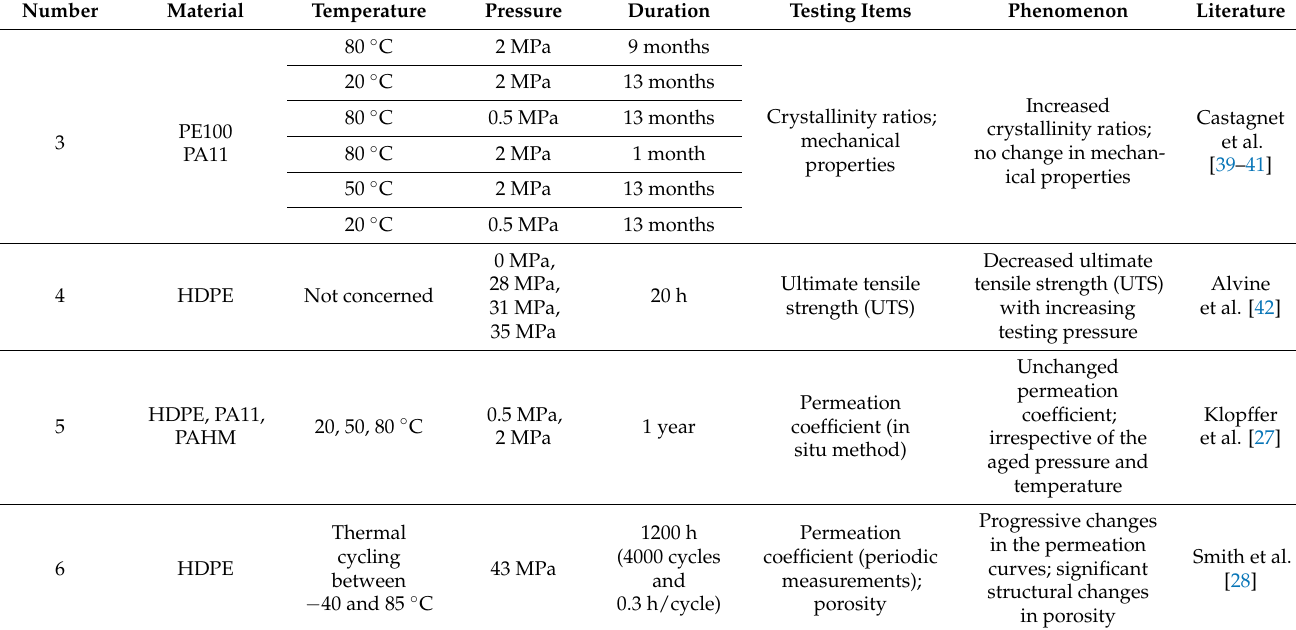
Figure 2. Arrhenius curves for HDPE [28]. Figure 3. Relationship of pre-exponential scaling factor and activation energy of Arrhenius equa- tion with temperature cycling intervals [28]. 4.2. Ageing Test Conditions of Liners in Hydrogen Environment The ageing test conditions, such as exposure time, temperature, pressure, humidity, and depressurization rate are not consistent among the three existing standards, as Table 6 shows.